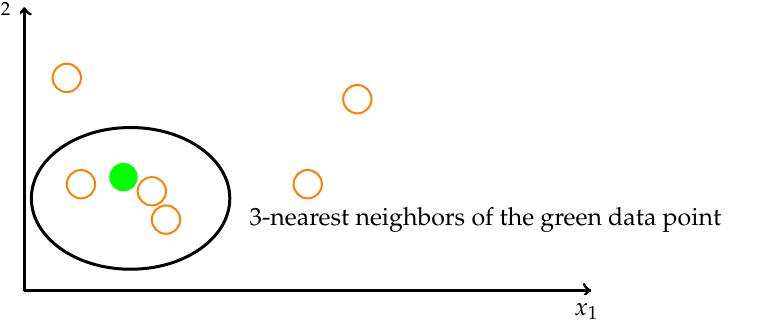
Figure 7. The theory of KNN